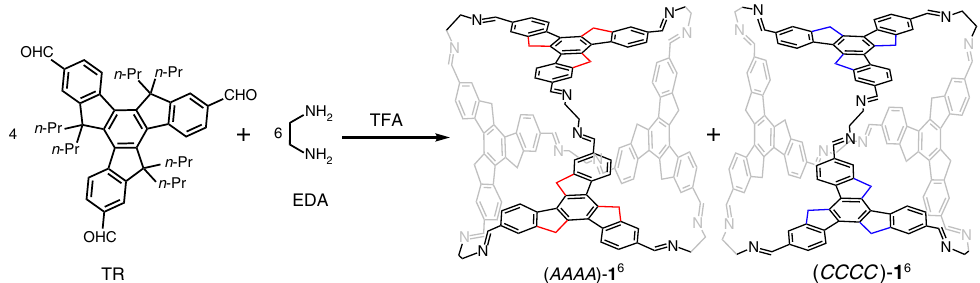
Fig. 1 Synthesis of chiral octahedra ( CCCC )- 1 6 and ( AAAA )- 1 6 with facial rotational patterns. Four truxene faces react with six EDA-linked vertices to give tetra-capped octahedral enantiomers. The C 3 h -symmetric truxene face loses its σ h mirror symmetry in the octahedra and brings either a clockwise ( C ) or an anticlockwise ( A ) rotation on the exterior faces, as shown with blue or red lines. These con fi gurations of the two octahedra are named after the directionalities of the facial rotations as CCCC and AAAA . The propyl groups are omitted in the octahedra